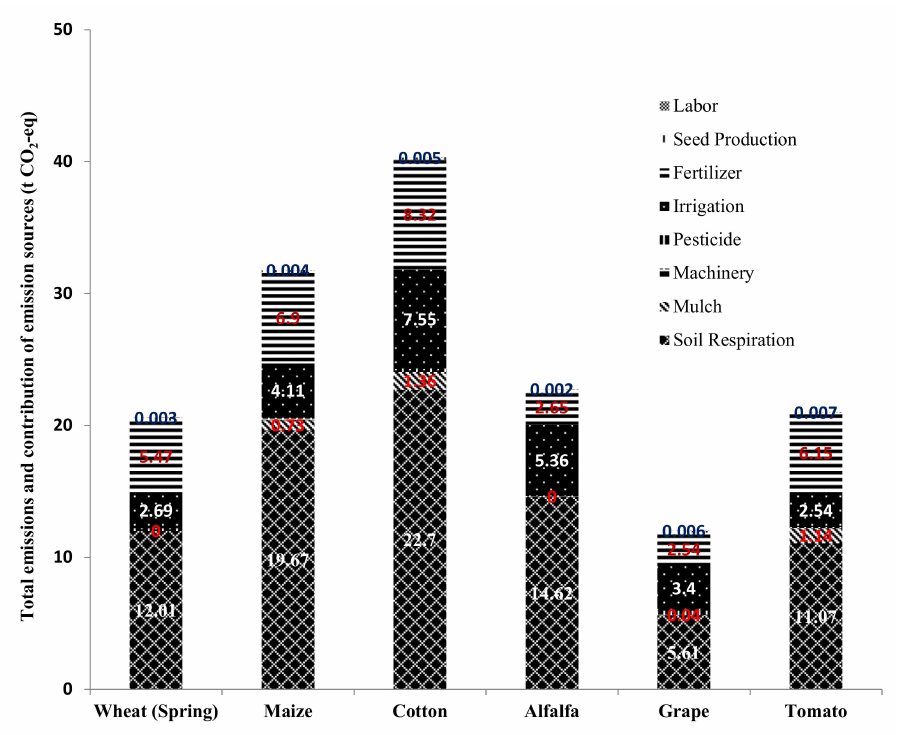
Figure 2. Total GHG emissions from crop production and the contribution of emission